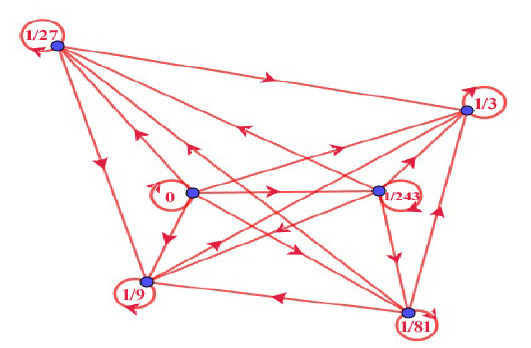
Figure 3. Related graph in which M b